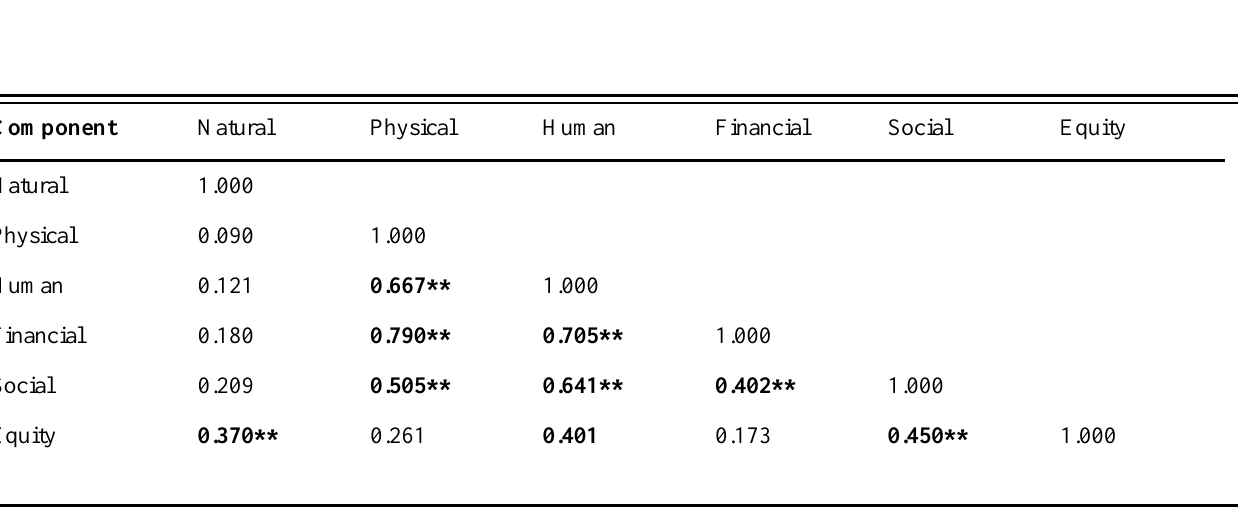
Table 4. Correlation coefficients of aggregate livelihood